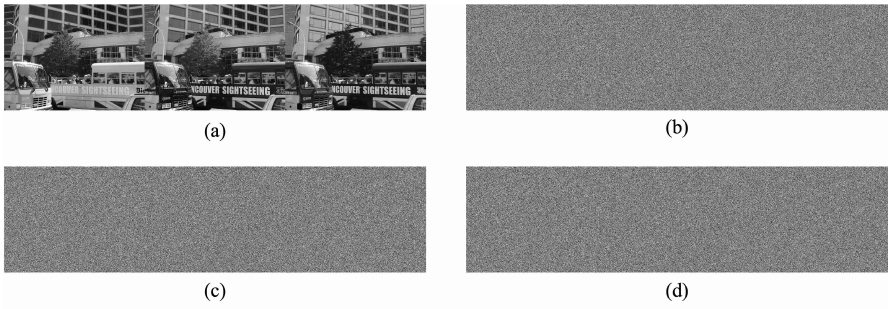
Figure 12. Marked encrypted images (ihc5 (original)). ( a ) Grayscale-based image; ( b ) L = 1; ( c ) L = 3; ( d ) L =